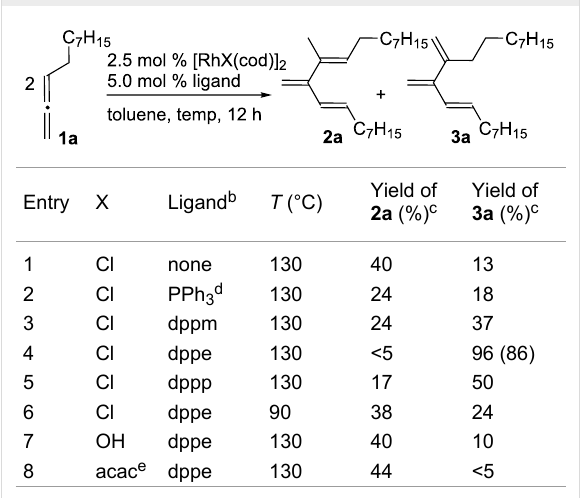
Table 1: Optimization of reaction conditions a